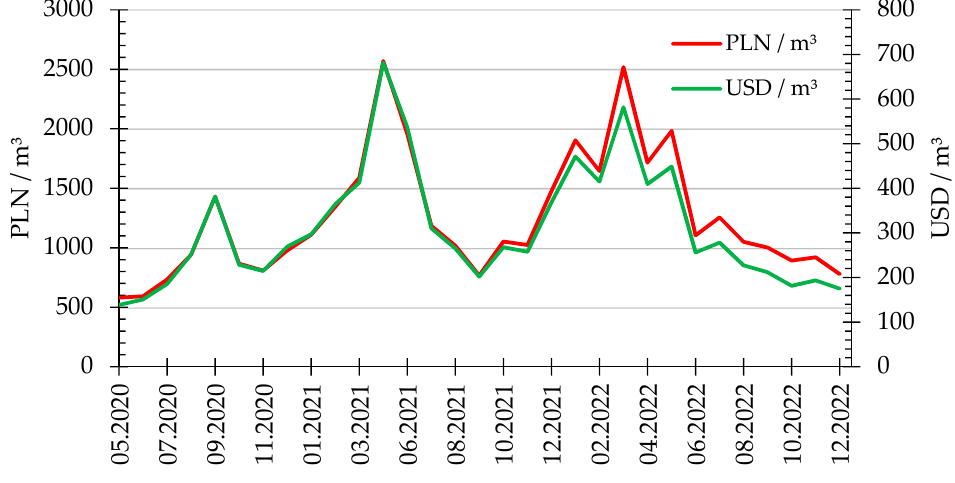
Figure 2. Change in average timber prices on the Polish market (data sources: [8,9]).